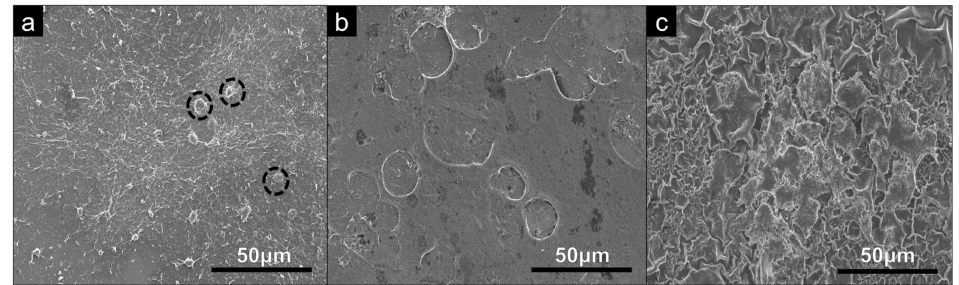
Figure 6. SEM analysis of U-2 OS cells seeded on square glass cover slips coated with ( a ) PEI coating, ( b ) PDDA coating and ( c ) CHI coating, examined at a magnification of × 1k and cultured under standard conditions for 7 days.